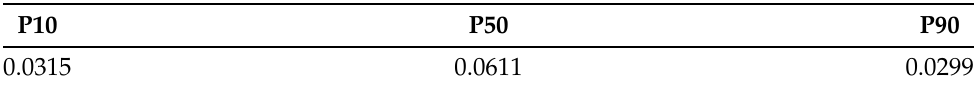
Table 11. Quantile loss for test